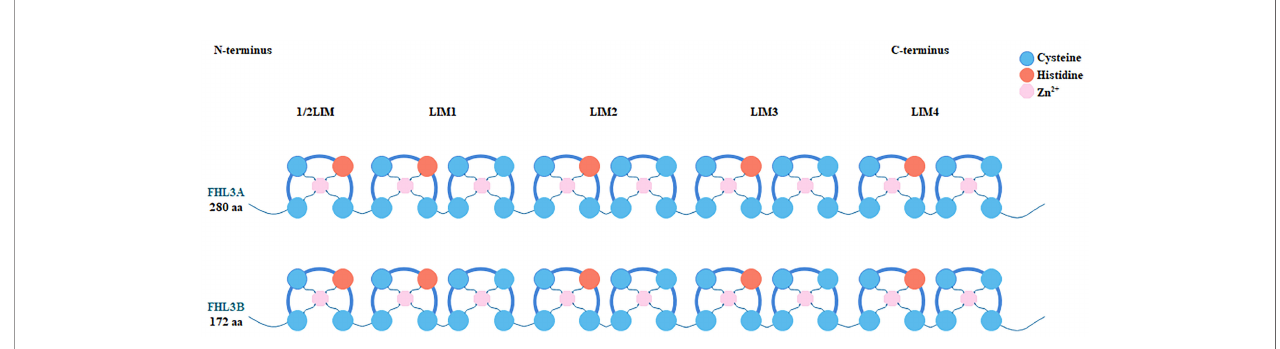
FIGURE 2 | Each member of the FHL protein family consists of four complete LIM domains and an N-terminal single zinc fi nger domain, the sequence of the latter corresponding to the C-terminal half of the LIM motif. Histidine and cysteine residues coordinate the binding of two Zn 2+ ions per LIM domain, which helps stabilize the secondary and tertiary structure of FHL3 protein. Two isoforms of FHL3 are shown in the fi gure. Isoform 1 comprises 280 and isoform 2 comprises 172 amino